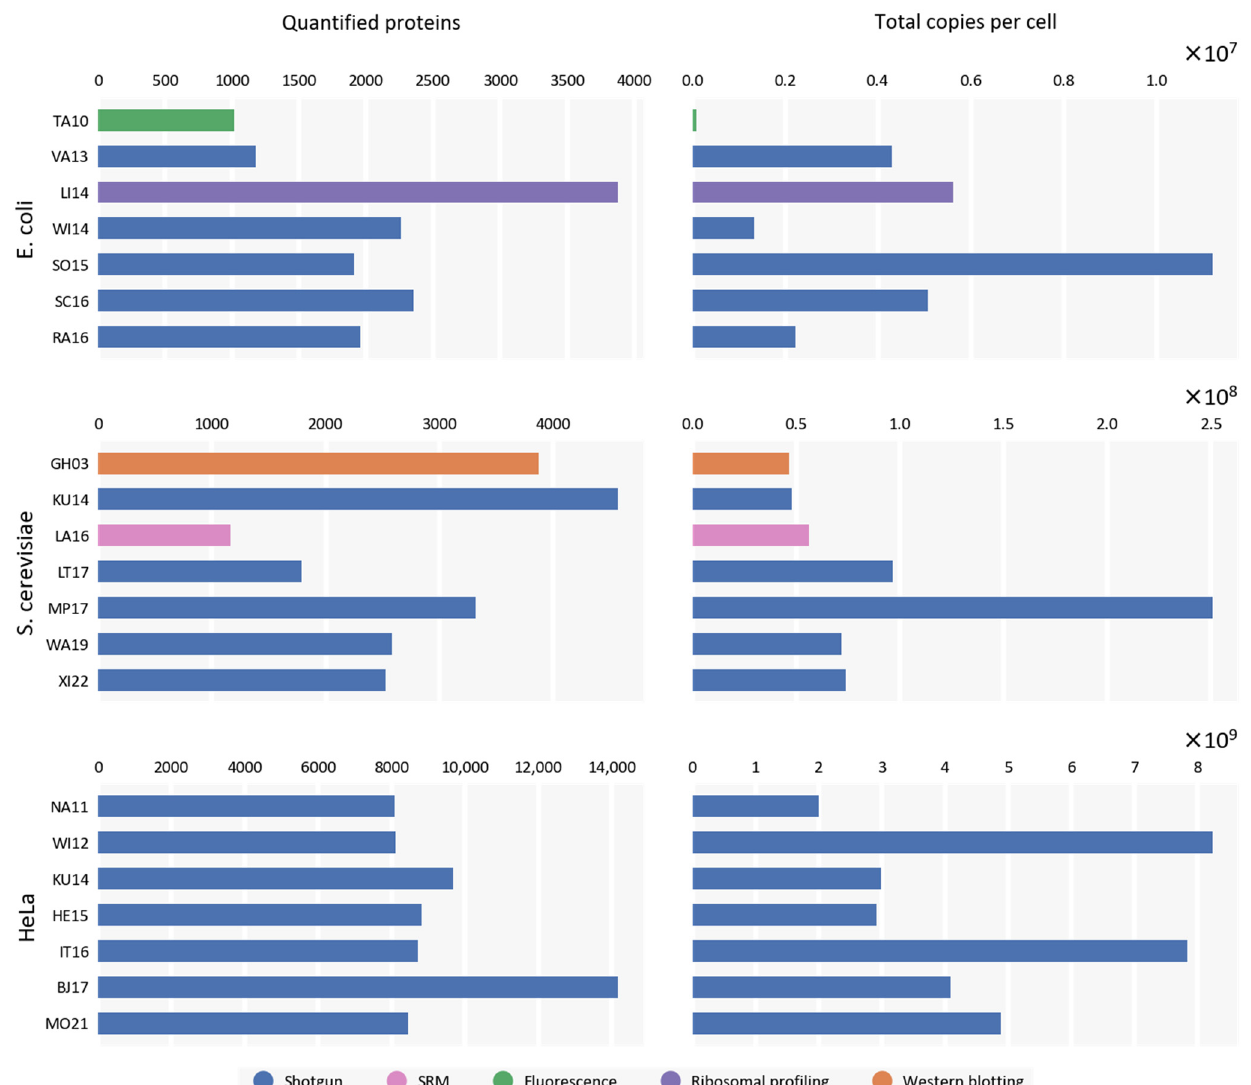
Figure 1. Results of proteomic studies in terms of the number of quantified proteins and total protein copies per cell for E. coli , S. cerevisiae , and